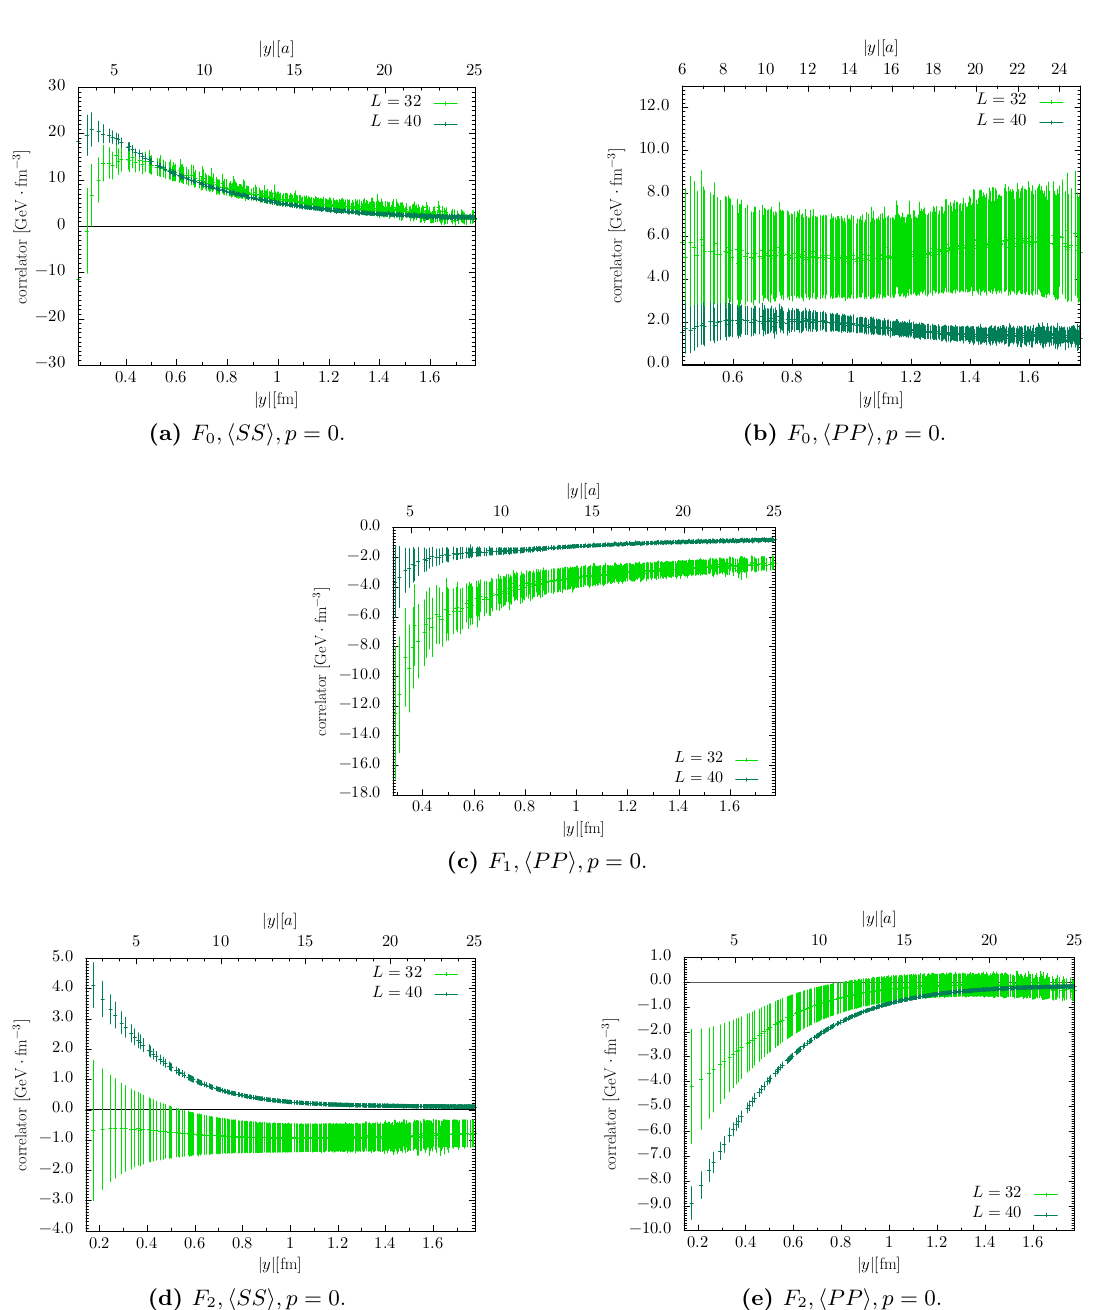
Figure 21. Lattice results for isospin amplitudes of very large statistical errors and is not